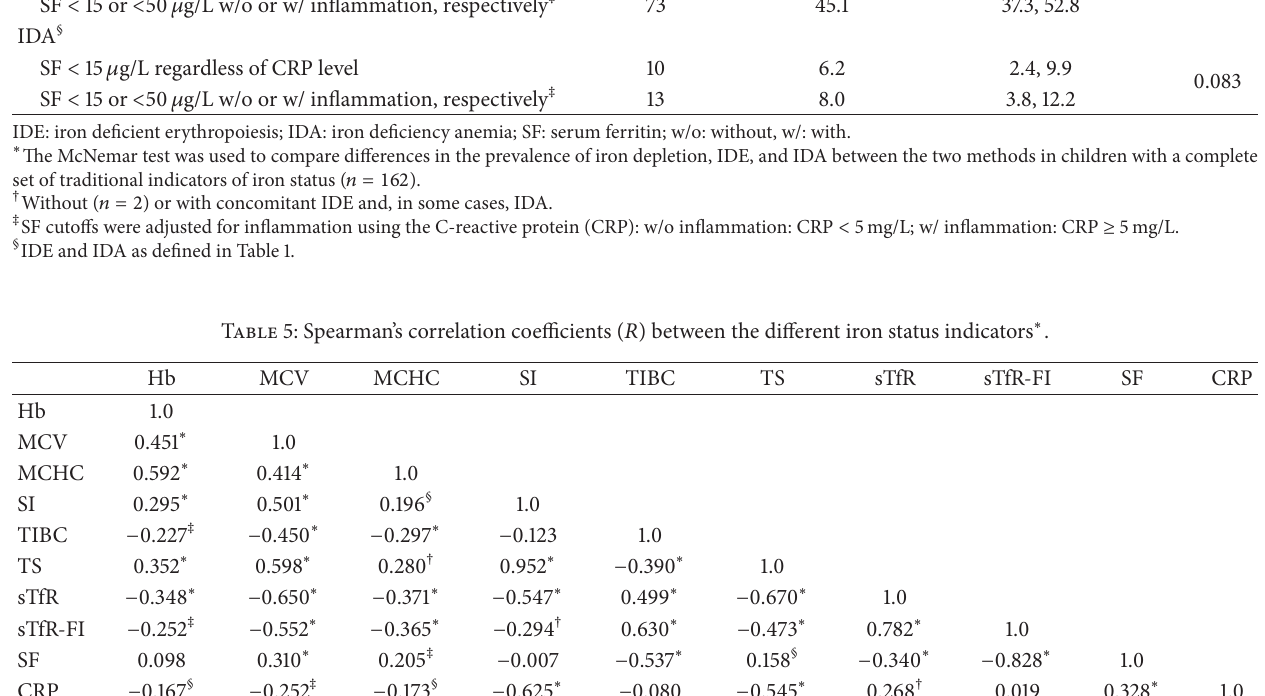
Abbreviations are as defined in Table 3. ∗ With the exception of correlation coefficients involving sTfR and sTfR-FI for which the n varied between 141 and 149 participants and MCHC between